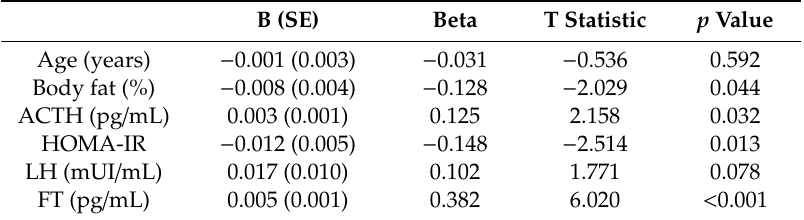
Table 4. Multiple linear regression analysis: factors related to 17-OH progesterone levels. B